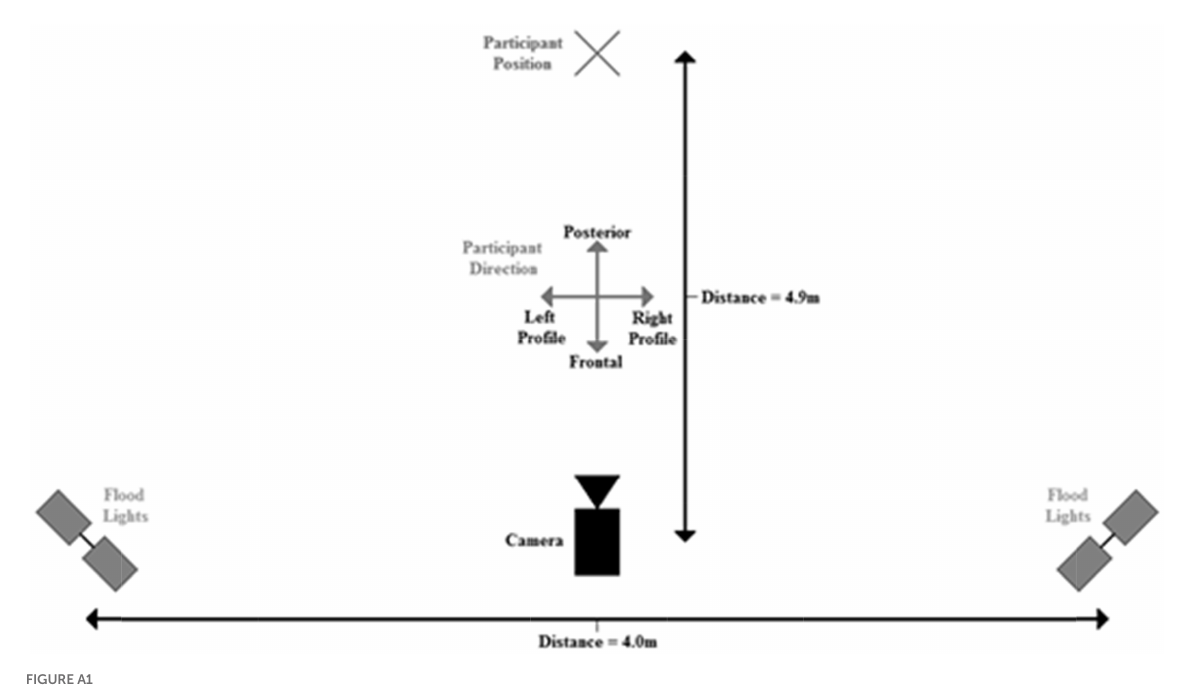
FIGURE A1 Equipment layout during stimulus